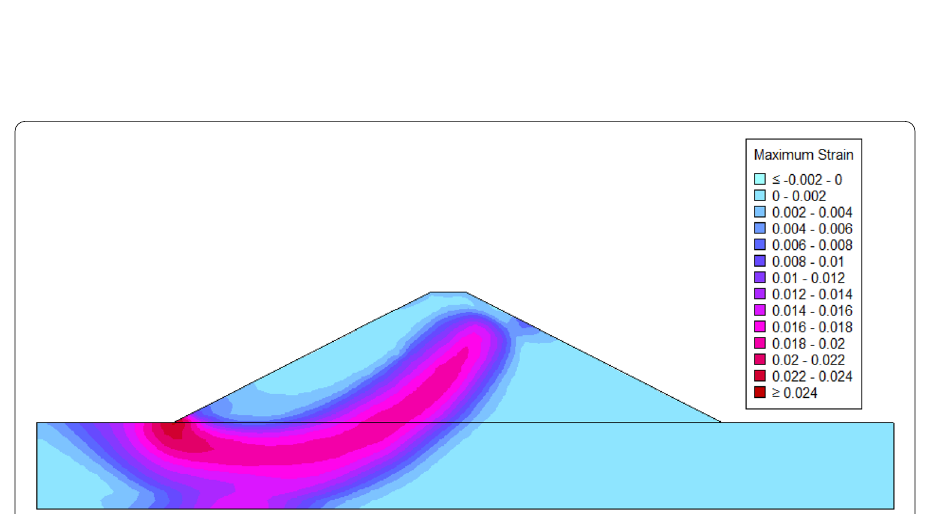
Fig. 22 Maximum strain contours within the earthen dam upon completion of reservoir drawdown on the 5th day